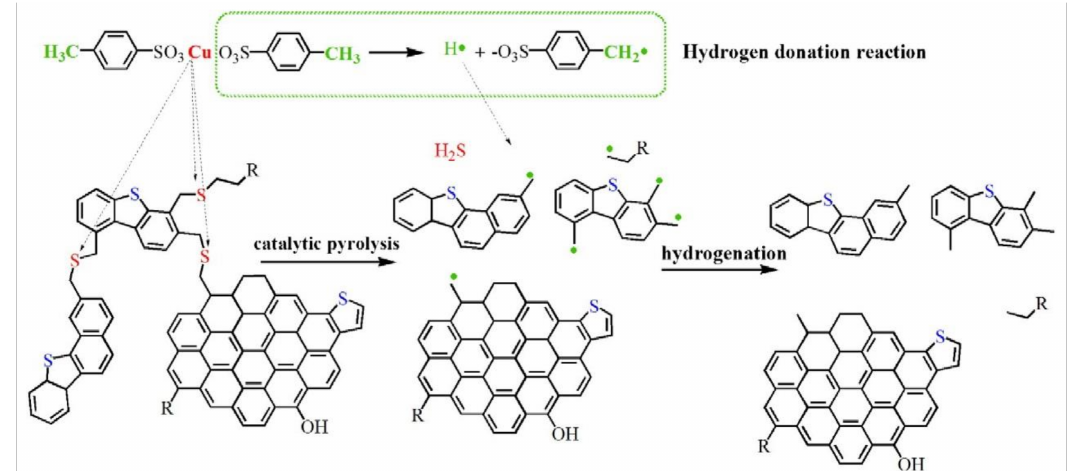
Figure 5. The destruction mechanism of C-S